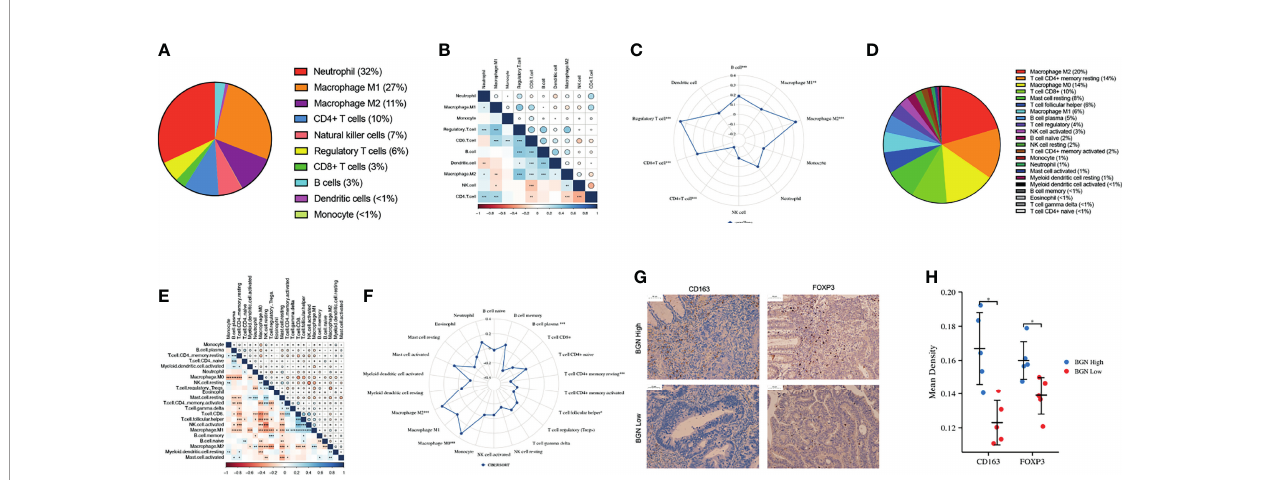
FIGURE 5 | TIIC pro fi le in colon cancer samples and correlation analysis. (A, D) Pieplots showing the estimated proportion of different kinds of TIICs in colon tumor samples prediceted by (A) quanTIseq and (D) CIBERSORT. (B, E) Pearson correlation matrix of the different TIIC proportions in the colon cancer microenvironment quanti fi ed by (B) quanTIseq and (E) CIBERSORT. The size of each bubble and shadow of each tiny color box both represented a corresponding correlation value between two cells. Asterisks in each tiny box, indicating the p-value of the correlation between two cells. (C, F) Radar chart showing the correlation between BGN expression and different proportions of TIIC analyzed by (C) quanTIseq and (F) CIBERSORT. (G) Representative images of IHC staining for CD163 and FOXP3 in BGN high and low expression groups. (H) Quanti fi cation of IHC staining intensity for CD163 and FOXP3 in BGN high and low expression groups. Wilcoxon rank sum test served as the statistical signi fi cance test. *p < 0.05, **p < 0.01. ***p <